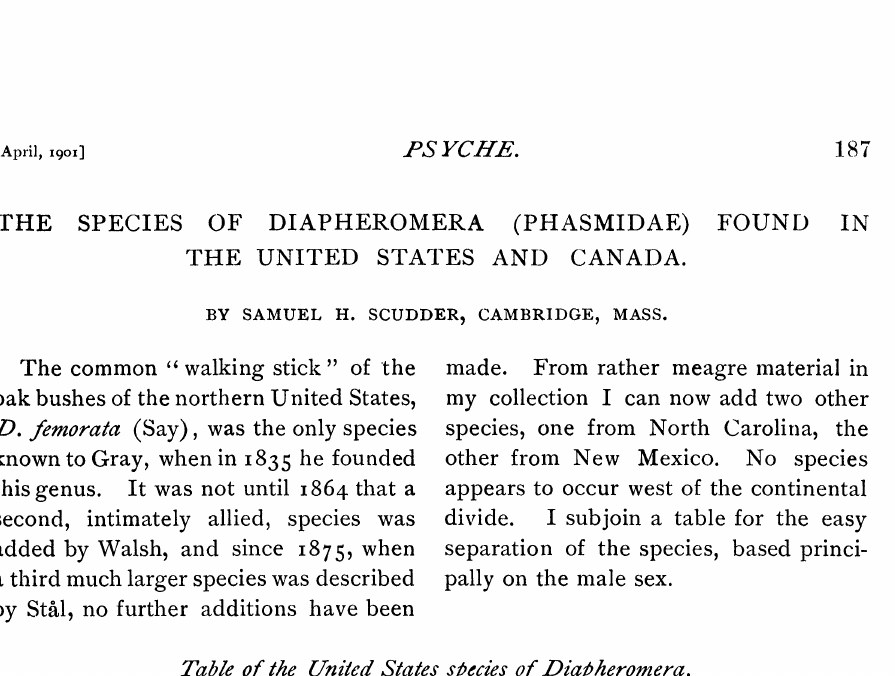
Table of #ze United States s2ecies of